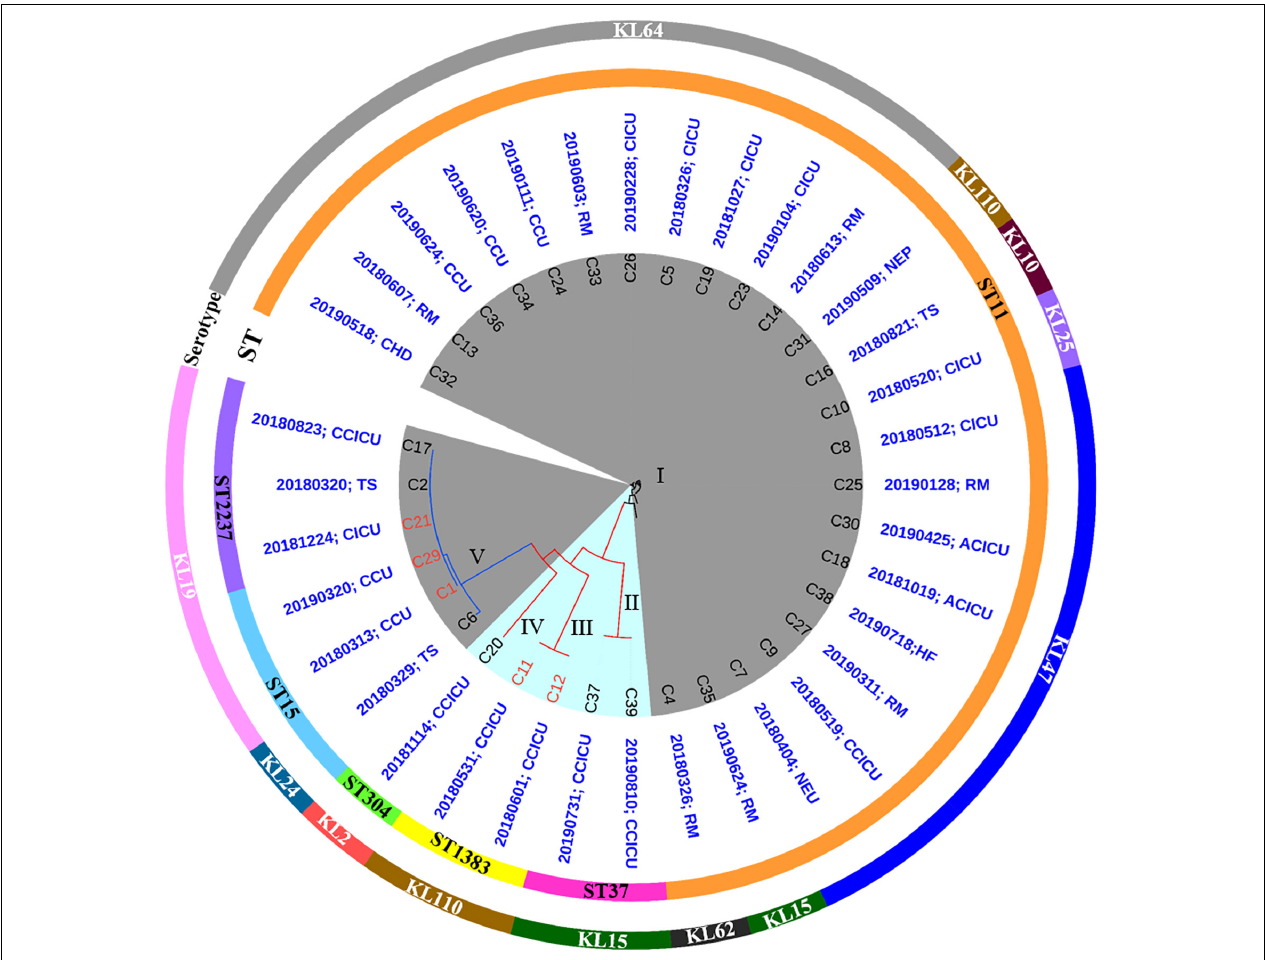
FIGURE 1 | Phylogenetic analysis of 35 CRKP isolates and their basic characterization. bla NDM − 1 - and bla KPC − 2 -positive strains are highlighted in blue and gray background, respectively. Circles outside the tree indicate the STs and serotypes of each strain. The isolation time and sites are shown in blue words (RM, respiratory medicine ward; CHD, coronary heart disease ward; CCU, coronary care unit; CICU, comprehensive intensive care unit; NEP, nephrology ward; TS, thoracic surgery ward; ACICU, adult cardiac intensive care unit; HF, heart failure ward; NEU, neurology ward; CCICU, children cardiac intensive care unit). The labels marked in red represent the carbapenem resistance phenotype could successfully transfer by